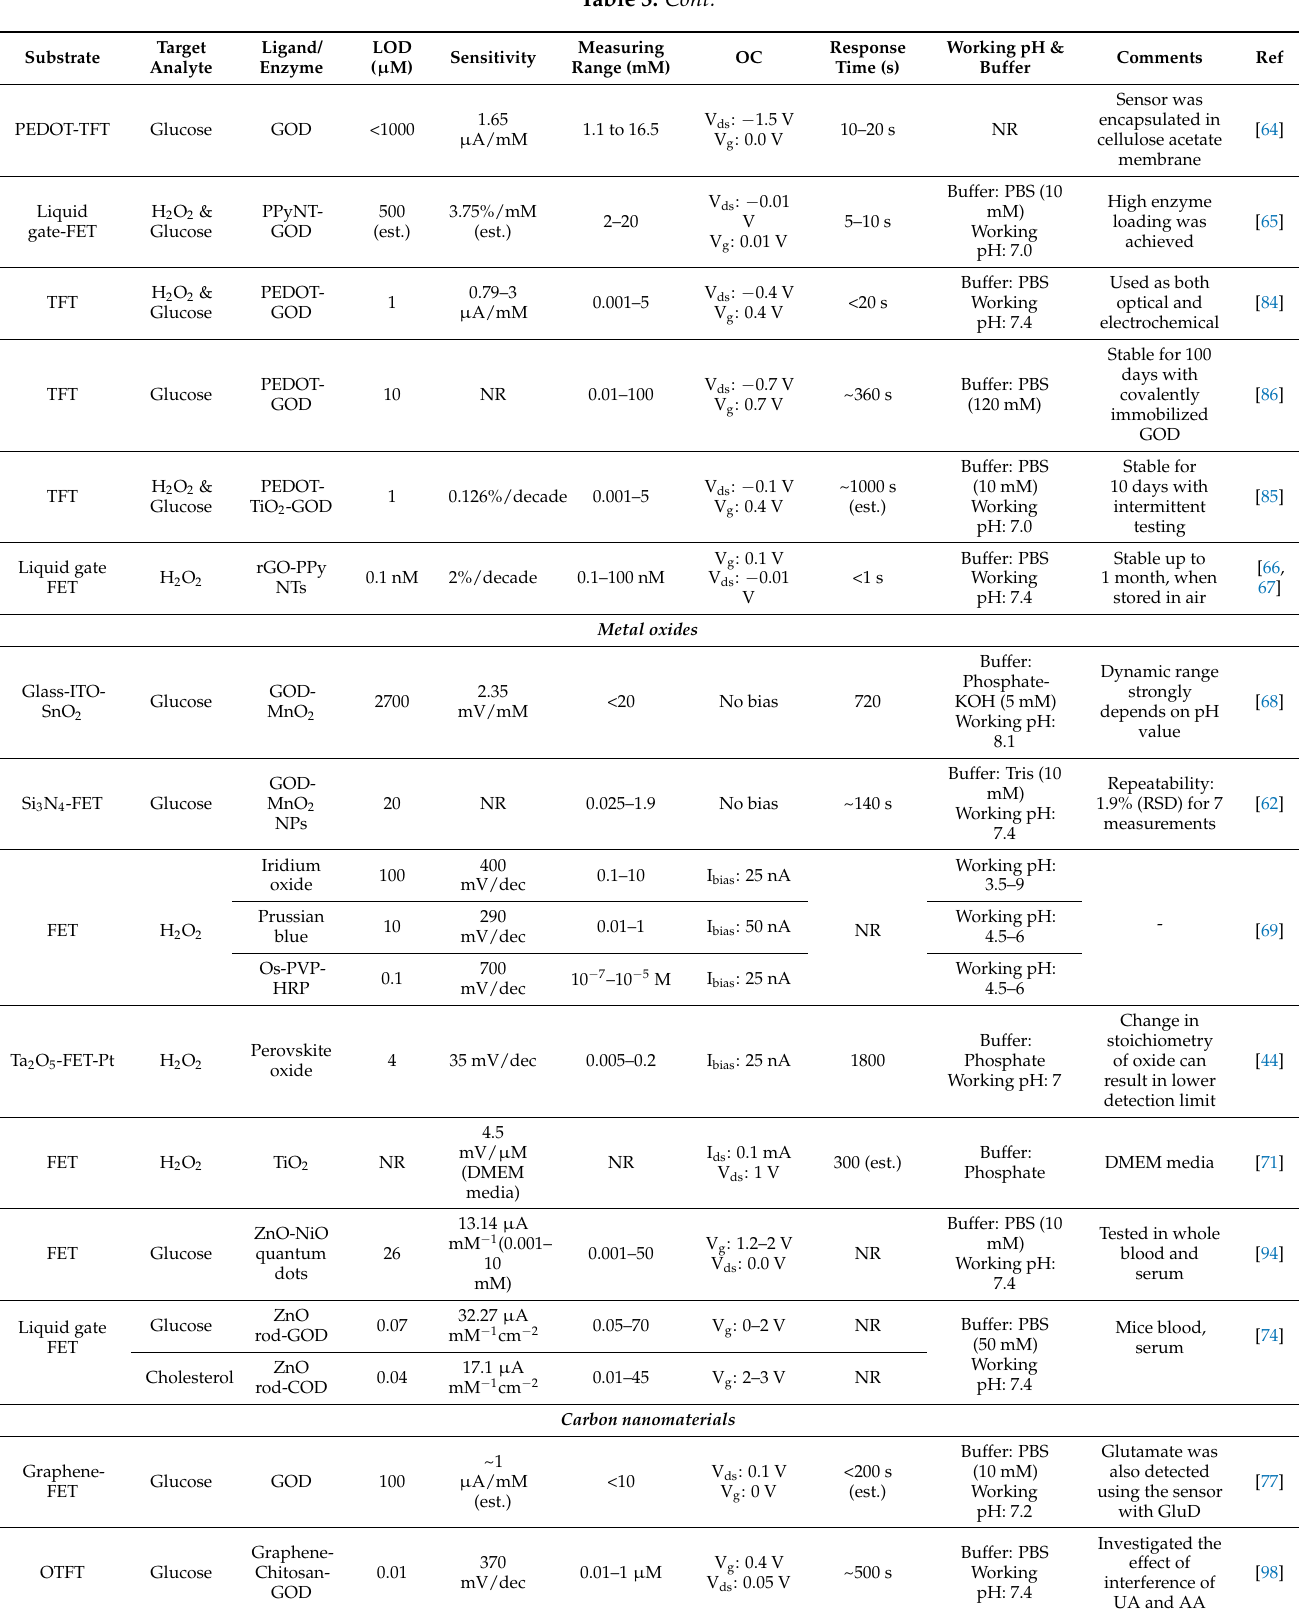
Glutamate was also detected using the sensor with GluD Investigated the effect of interference of UA and